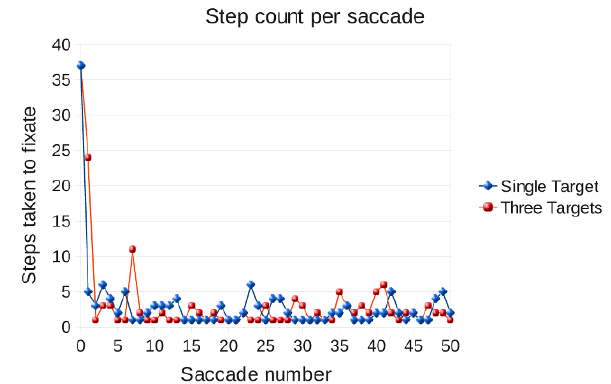
Figure 4. Graph showing the number of movements taken to fixate on a tar- get. Only the first 50 saccades are shown, with no head movement involved. Best viewed in colour.